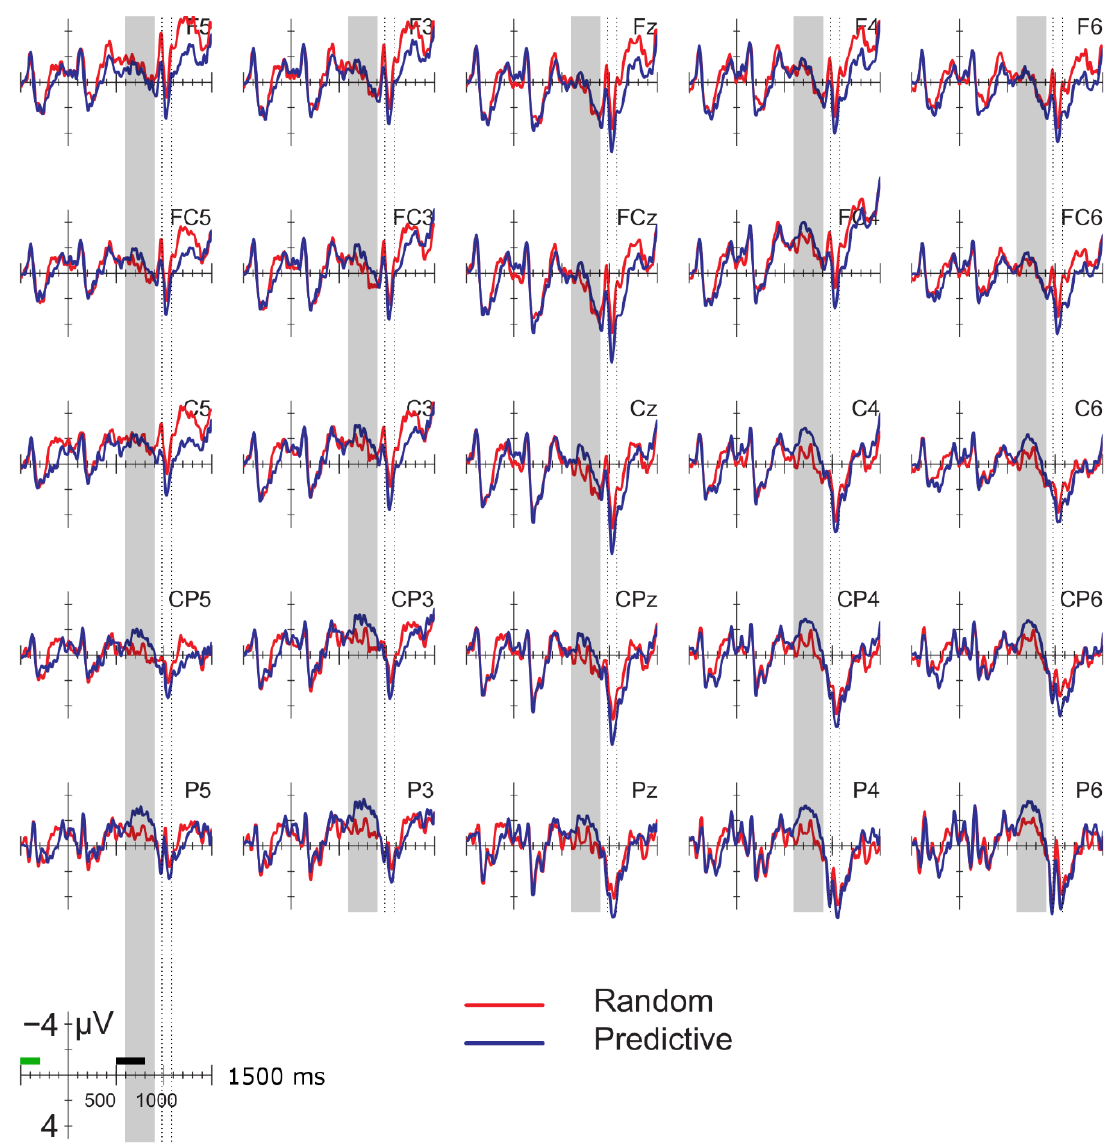
Figure 1. Event-related potentials (ERPs) time-locked to the onset of the pre-delay letter in the delay conditions for 25 selected electrodes (left hemisphere (F3, F5, FC3, FC5, C3, C5, CP3, CP5, P3, P5); midline (Fz, FCz, Cz, CPz, Pz); right hemisphere (F4, F6, FC4, FC6, C4, C6, CP4, CP6, P4, P6). The delay period (500–800 ms) is indicated with the black bar above the time scale; the letter following the delay starts at 800 ms. Blue line: predictive (alphabetic) condition; red line: random condition. Gray vertical bar: 600–900-ms interval used for the analysis of the effects during the delay; vertical dotted lines: analysis window for the P2/P3 effects. ERPs are baselined to the 200 ms following the onset of the second letter before the potential delay (−500 to −300 ms, see the green bar above the time scale). In this and the following figures, negative is plotted